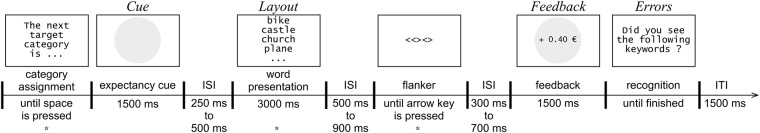
Trial structure, Study 1.Visual depiction of the trial structure described in the “Method” section. In this example, the circle was associated to a possible gain (reward) and a reward was eventually allocated. All trials followed this structure. Above each phase, the variable name of interest is shown in italics. Asterisks mark phases during which Study 1 differed from studies 2 and 3.